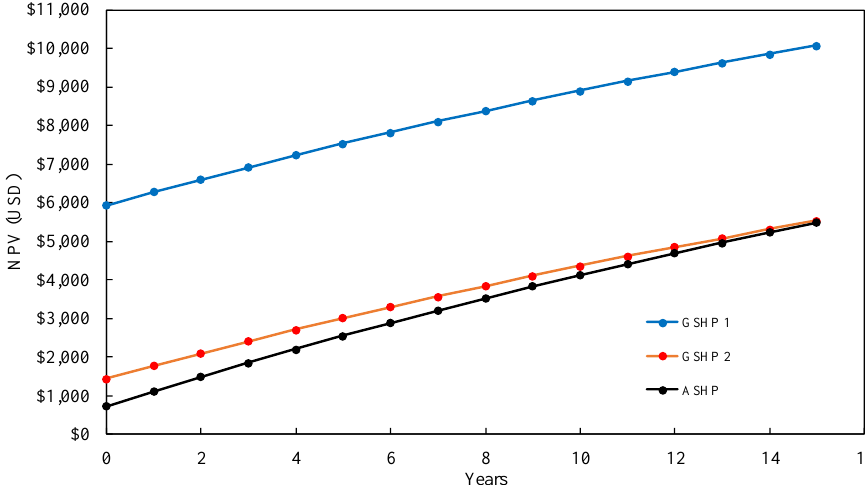
Figure 19. The net present value (NPV) of the heat pumps (in the base case scenario).